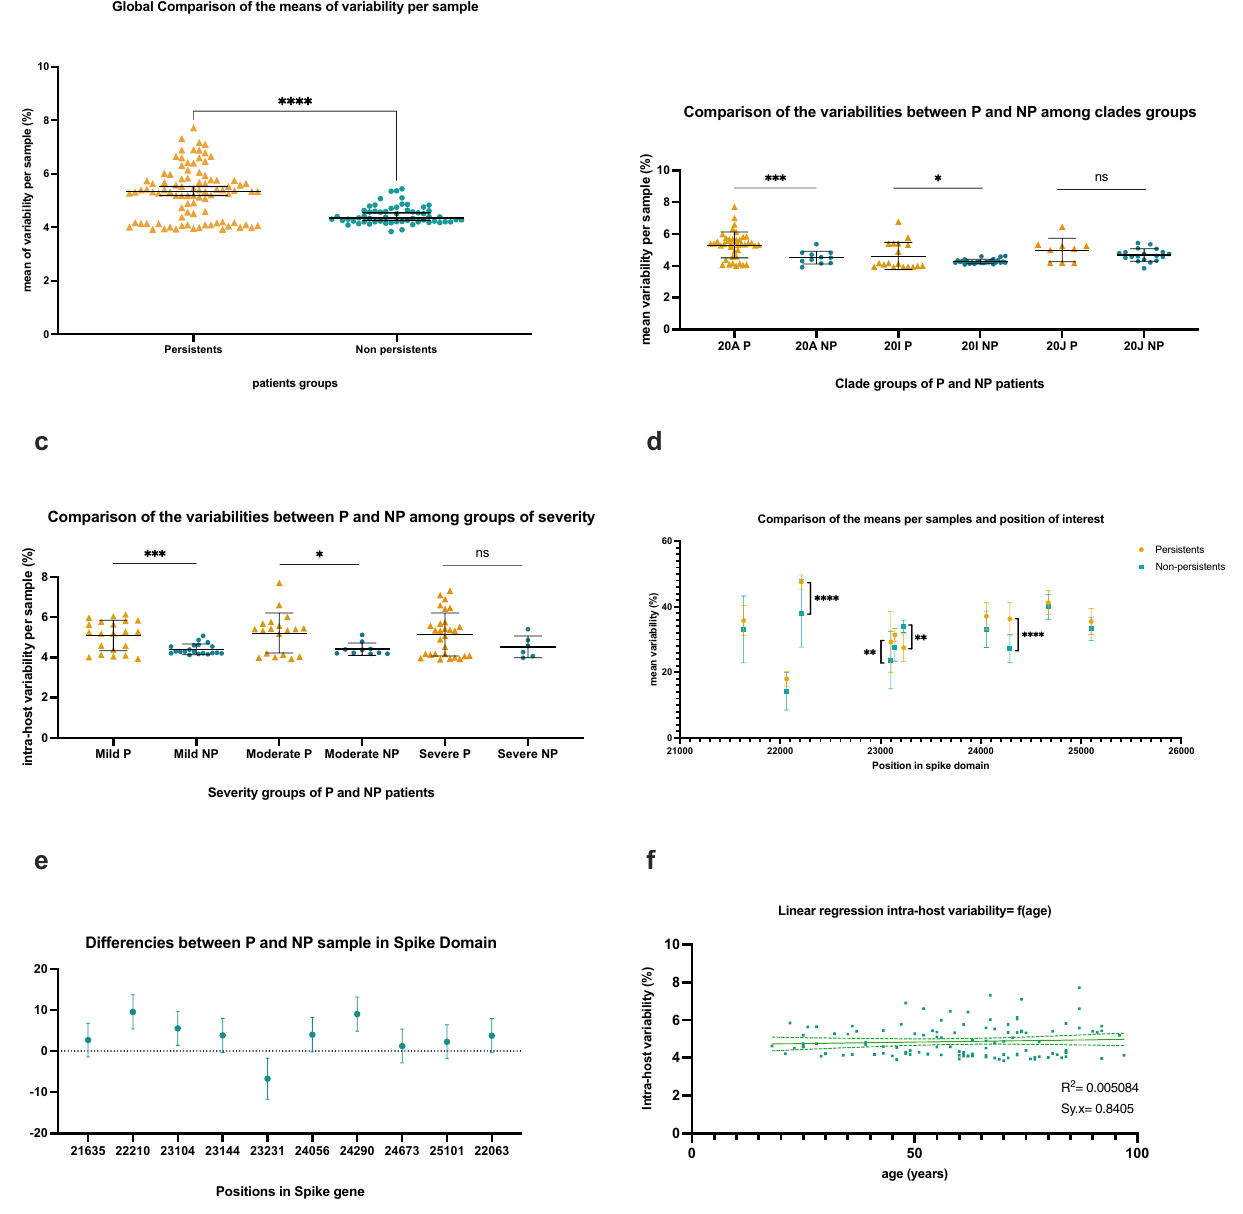
Figure 2. Comparison of intra-host variability among several criteria between samples from persistent (yellow) and non-persistent (blue) patients. ( a ) global comparison of intra-host variability per sample. Welch’s t comparison test. ( b ) differences between clades. Kolmogorov–smirnov comparison test. ( c ) differences between severity of COVID-19. Unpaired t test used. ( d ) Hotspot mutations in spike domain. Mixed effect analysis, Šídák’s multiple comparisons test. ( e )Variance’s comparison in spike domain. Mixed effect analysis, Šídák’s multiple comparisons test. ( f ) linear regression between intra-host variability and age. Simple linear regression